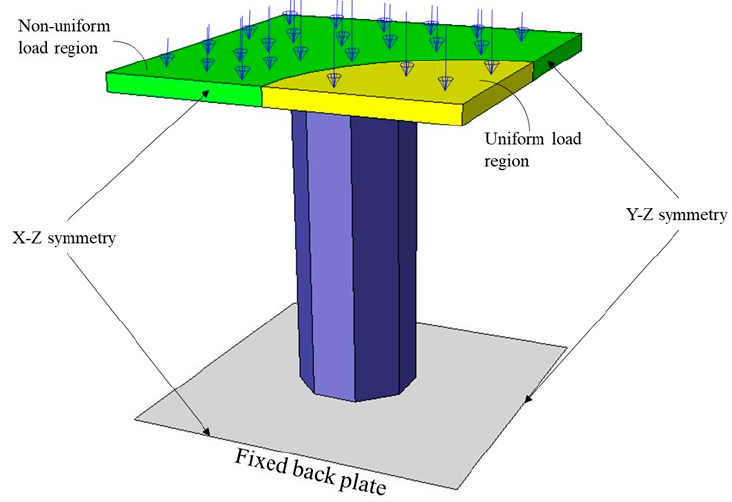
Figure 6. Quarter-symmetry of the numerical model boundary and load conditions.